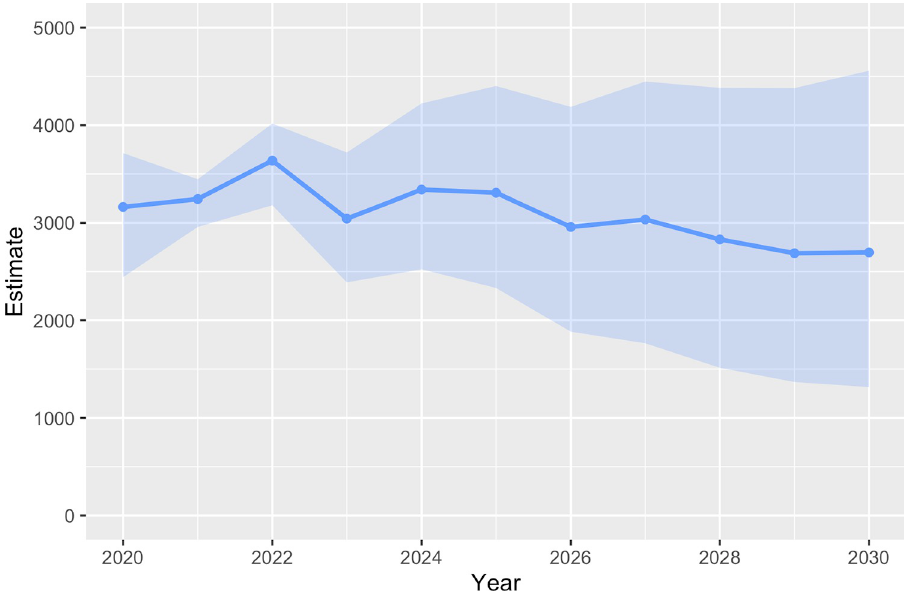
Fig 4. Moose population projection. Stochastic population projection of moose in Minnesota from 2020 to 2030 using forecasted estimates of annual survival and per-capita recruitment (number of calves that survived to 1 year per adult female alive during the previous year). Shaded regions represent 90% confidence intervals from 1,000 individual